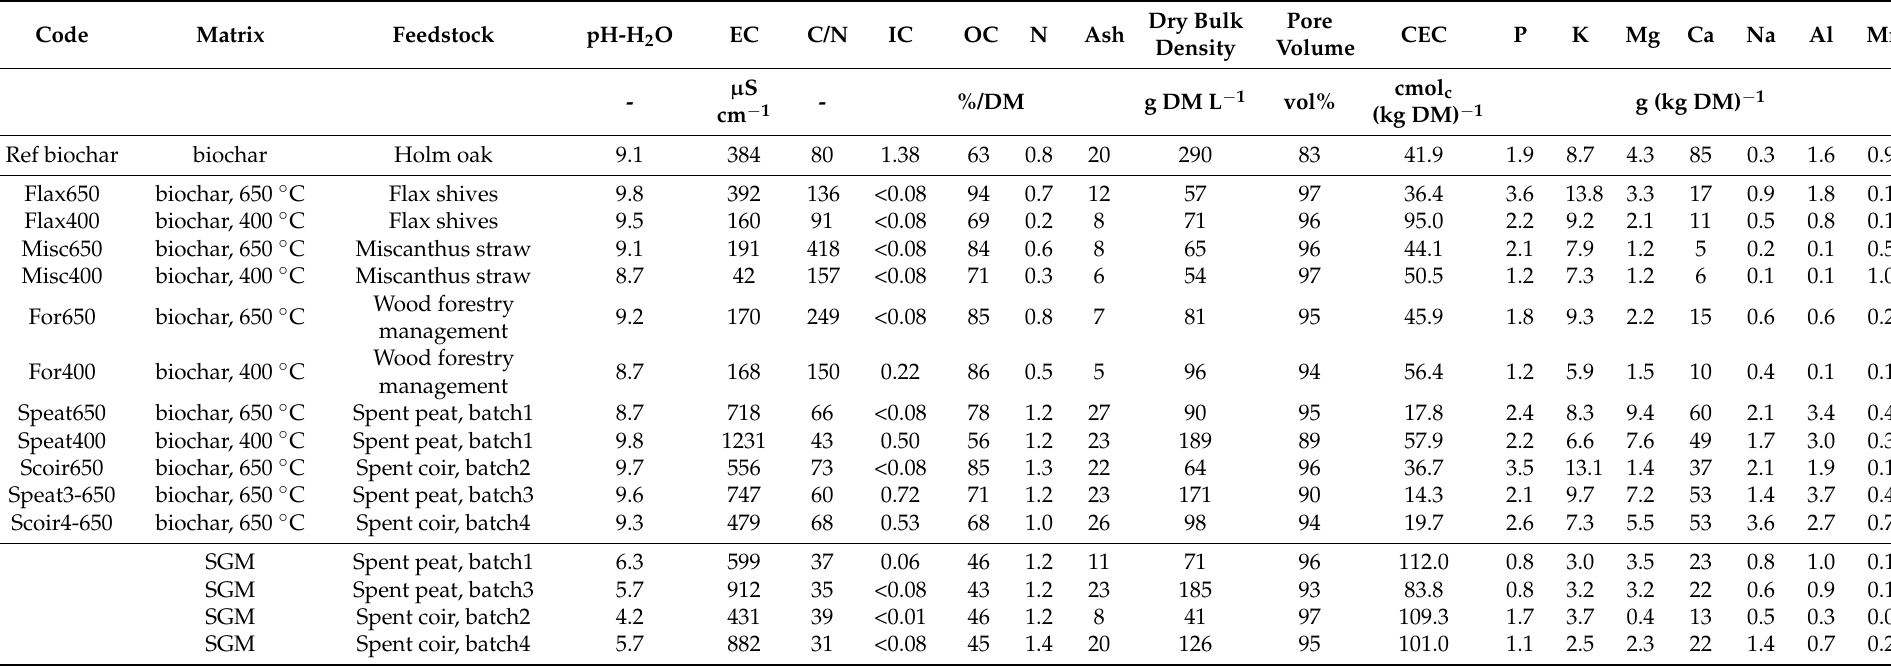
Table 1. pH, electrical conductivity (EC), total content of C (inorganic, IC and organic, OC), N, ash and total nutrients, dry bulk density, pore volume and cation exchange capacity (CEC) of spent growing media (SGM) feedstocks (below the line) and biochars (above the line) including the ref biochar (reference biochar based on stone oak wood). See material and method section for full